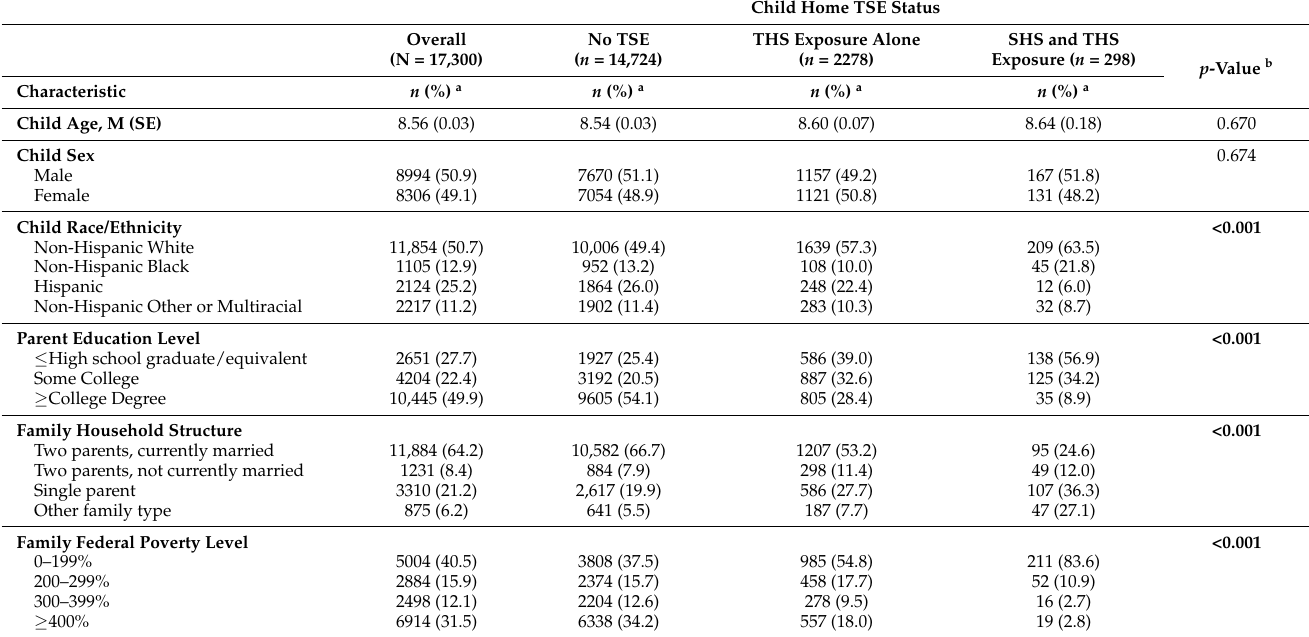
Table 1. Sociodemographic covariates and child home TSE status among U.S. children 6–11 Years Old, 2018–2019